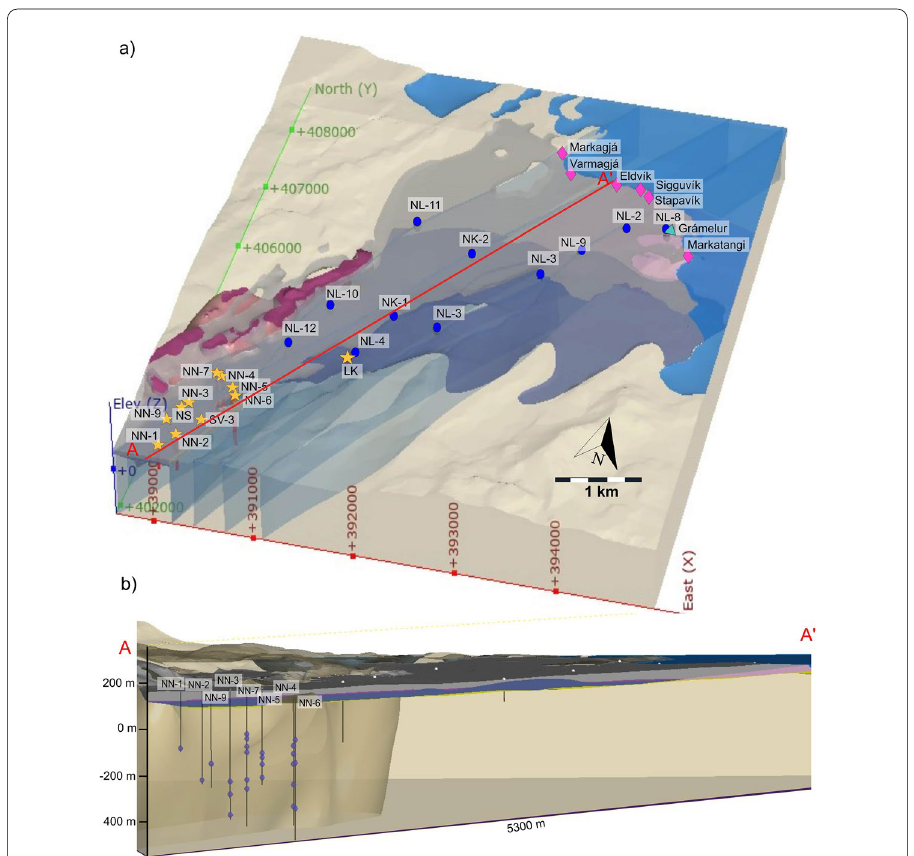
Fig. 3 a 3‑D geological model with projection of fault planes. b Cross section (trace shown in red in a ) showing the feedzones in blue spheres and injection wells in black NN‑1, NN‑02, NN‑03, NN‑04, NN‑05, NN‑06, NN‑07 and